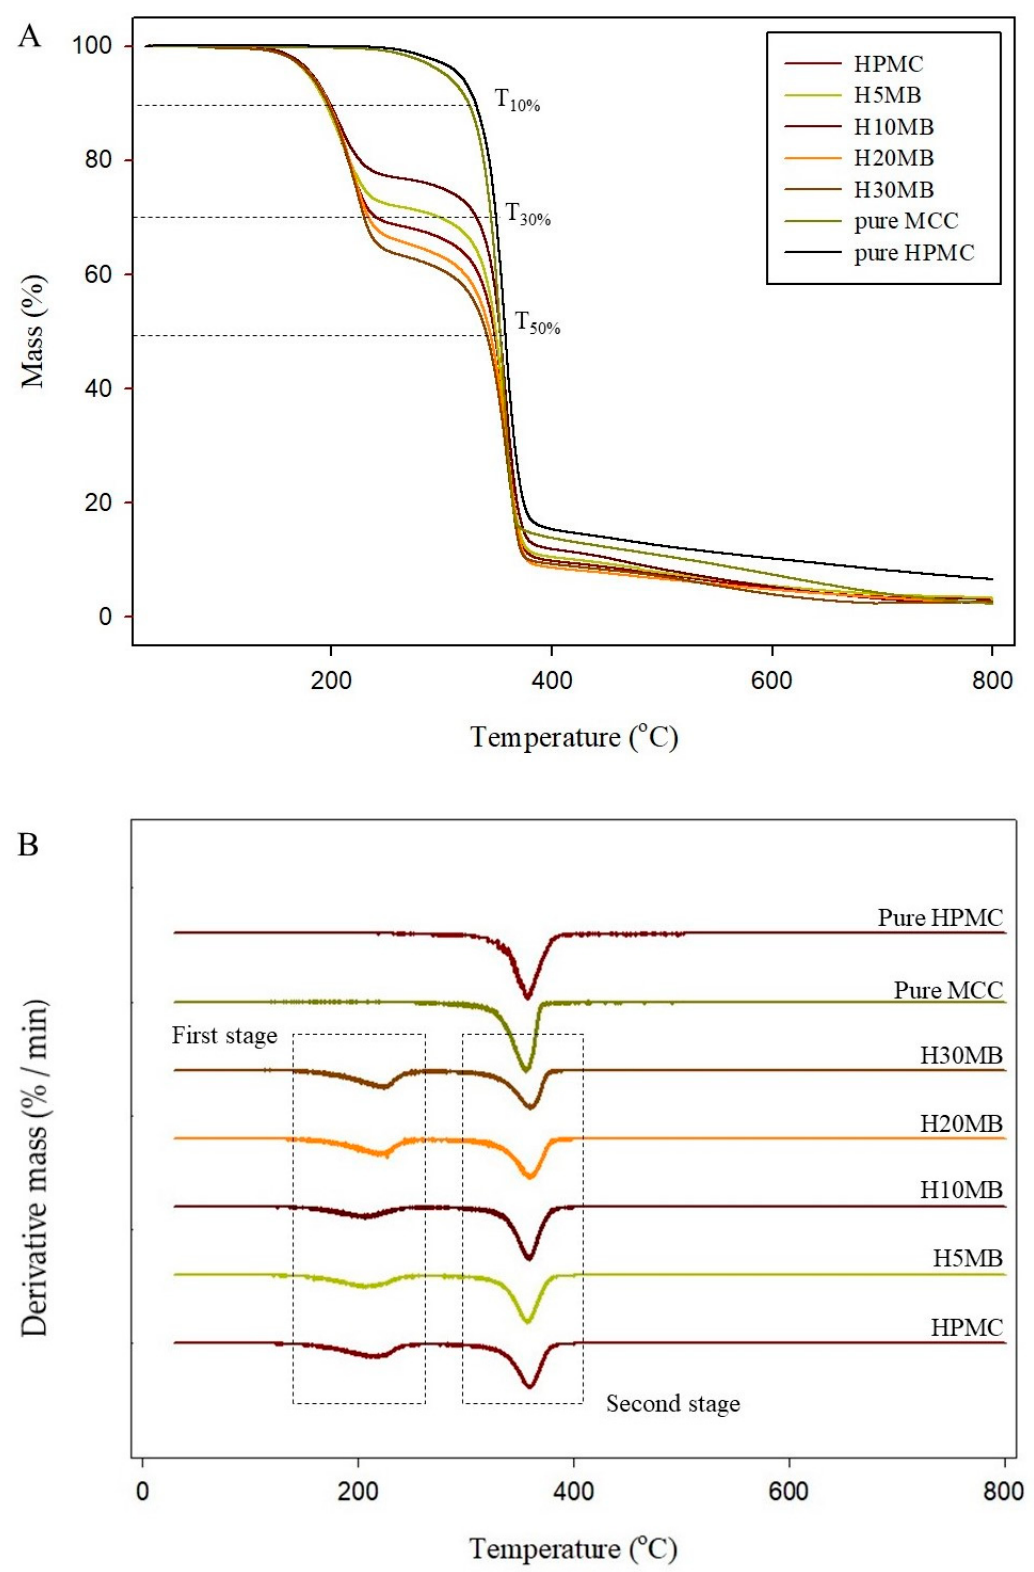
Figure 4. Thermogravimetry ( A ) and differential thermogravimetry ( B ) curves of the hydroxypropyl methylcellulose (HPMC), 5% microcrystalline cellulose (MCC) (H5MB), 10% MCC (H10MB), 20% MCC (H20MB), and 30% MCC (H30MB) films.